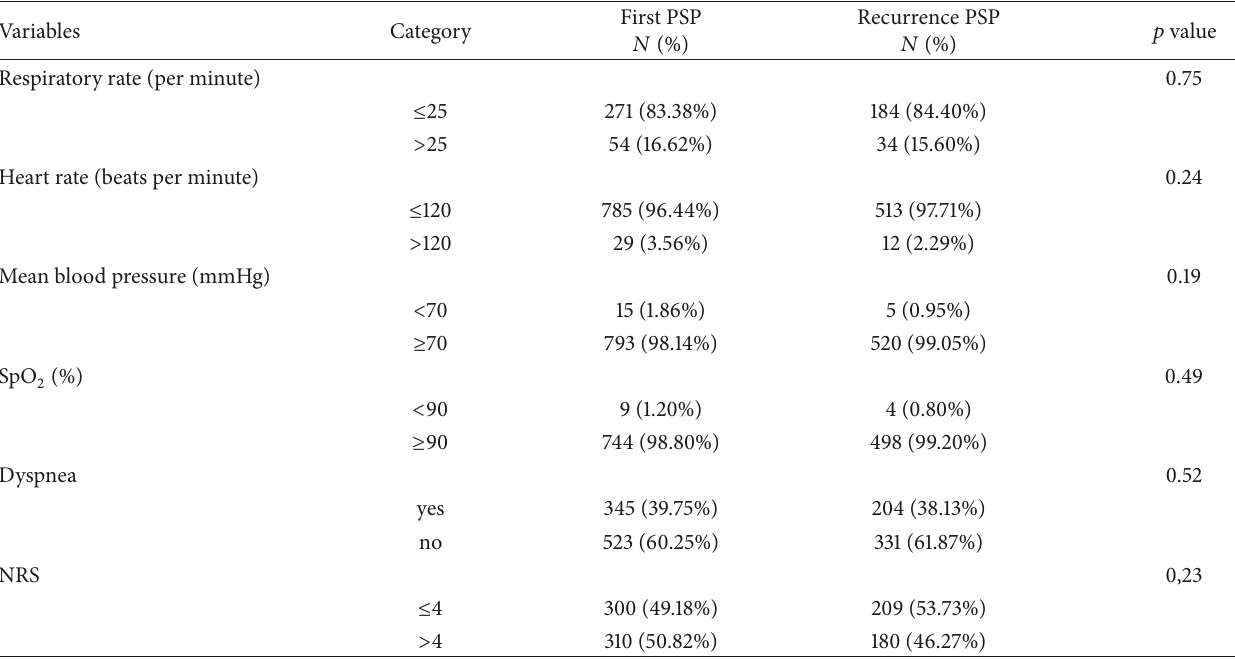
Table 2: Clinical presentation in first PSP and recurrence